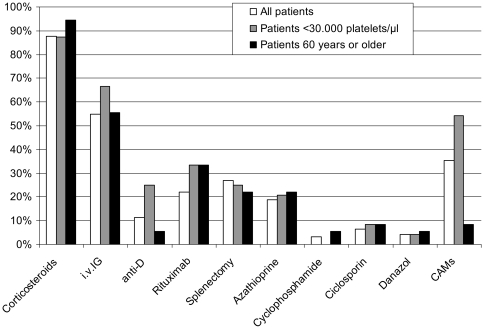
Analysis of the question: ‘What treatments have you ever received for your immune thrombocytopenic purpura?’.